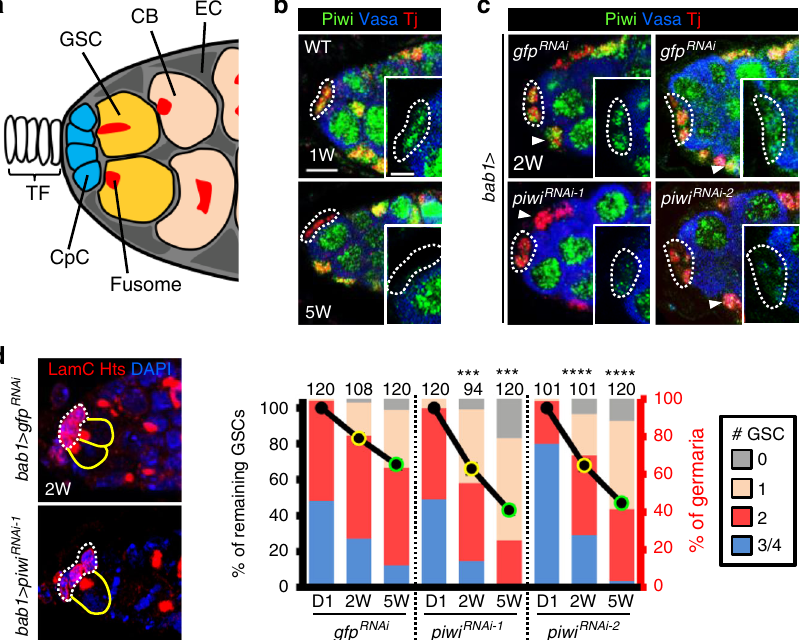
Fig. 1 Aging reduces Piwi expression in the niche leading to GSC loss. a The anterior region of Drosophila germarium. TF terminal fi lament, CpC cap cell, E escort cell, GSC germline stem cell, CB cystoblast. b Piwi expression is decreased in CpCs during aging (green, Piwi; blue, Vasa for germ cells; red, Tj for nuclei of CpCs and ECs). Scale bar, 5 μ m. Scale bar in inset image, 2.5 μ m. c Piwi expression is decreased in 2-week-old CpCs of bab1 > piwi RNAi germaria (green, Piwi; blue, Vasa; red, Tj). Arrowheads, ECs. d Left, GSC number is decreased in 2-week-old bab1 > piwi RNAi-1 germaria (red, LamC for CpC nuclear envelopes; red, Hts for fusomes; blue, DAPI for DNA). Dashed white circles, CpCs; yellow circles, GSCs. Right, GSC number in bab1 > gfp RNAi-1 , bab1 > piwi RNAi-1 , and bab1 > piwi RNAi-2 germaria at 1 day (D1), 2 weeks (2W), and 5 weeks (5W ) after eclosion. The numbers of analyzed germaria are shown above each bar. Percentage (%) of remaining GSCs (left y -axis) represents average GSC number at each time-point normalized to D1 within the same genotype; % of germaria (right y -axis) indicates the proportion of germaria carrying 0, 1, 2, 3, or 4 GSCs for the indicated genotype and age. Error bars of left y- axis, S.E.M., *** P < 0.001 (0.00011 for 2W piwi RNAi-1 and 0.0008 for 5W piwi RNAi-1 ); **** P < 0.0001, yellow and green outlines on symbols indicate that the % of remaining GSCs is signi fi cantly lower than D0 of the same genotype. Green outline on symbols indicates that the % of remaining GSCs is signi fi cantly lower than symbols with yellow outline within same genotype. Student ’ s t -test was used for comparisons of % remaining GSCs. All images ( b , c , and d ) are the same magni fi cation and share same scale bar with b . All inset images ( b , c ) are the same magni fi cation and share same scale bar with insert image of b . At least two biological replicates were performed for each